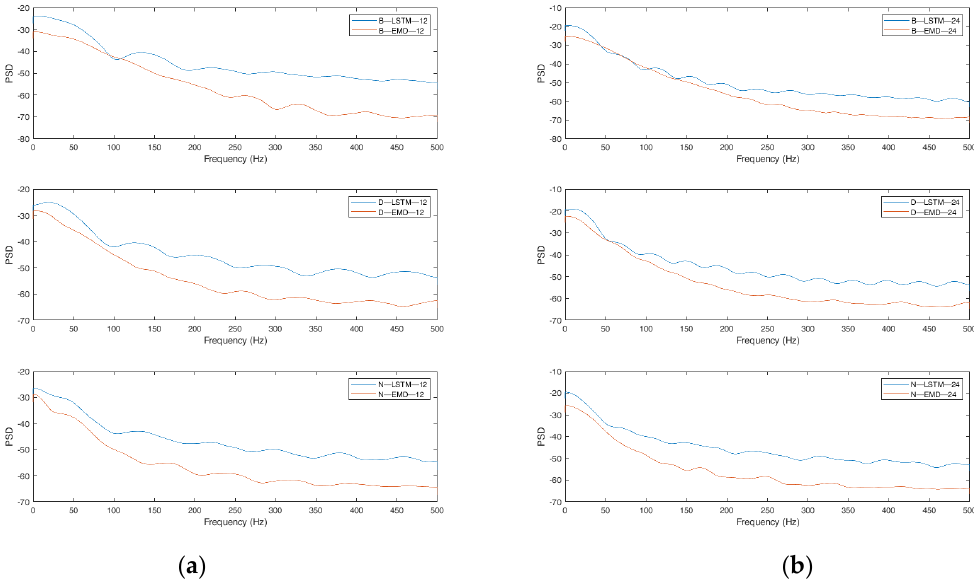
Figure 15. Power spectra of 12 and 24 h significant wave height. ( a ) represent the 12 h change curves of positions B, D, and N from top to bottom; ( b ) represent the 24 h change curves of positions B, D, and N from top to bottom.